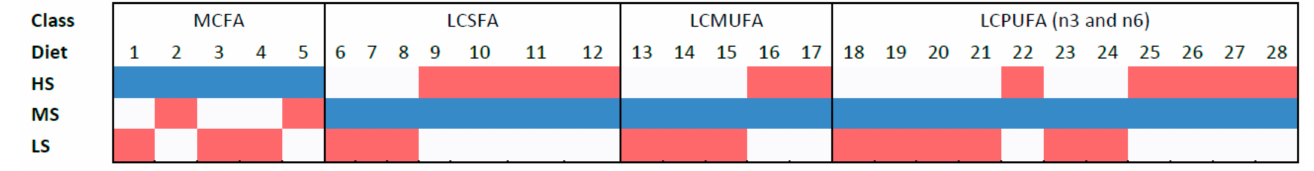
Figure 4. Serum non-esterified fatty acids heatmap of dogs ( n = 24) fed diets produced at high, medium and low shear (HS, MS and LS, respectively), with each individual group of fatty acids (MCFA: medium-chain fatty acids; LCSFA: long-chain saturated fatty acids; LCMUFA, long-chain mono-unsaturated fatty acids; LCPUFA, long-chain poly-unsaturated fatty acids). Log 2 values were conditionally formatted within each metabolite across diet on a color scale. Blue indicates a relative concentration lower than the other treatments, white indicates an intermediate relative concentration, and red indicates a higher relative concentration than the other treatments. 1, heptanoate (7:0); 2, caprylate (8:0); 3, caprate (10:0); 4, laurate